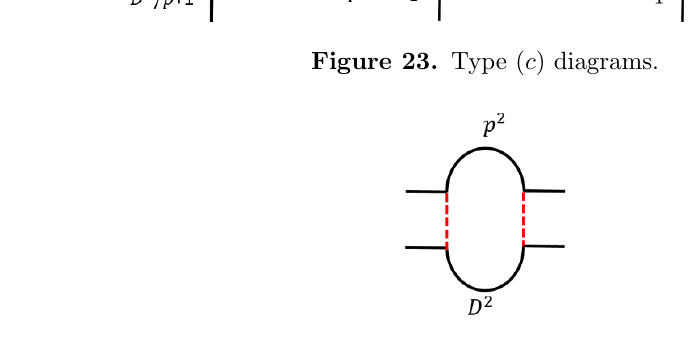
Figure 24. Type ( d ) diagrams.